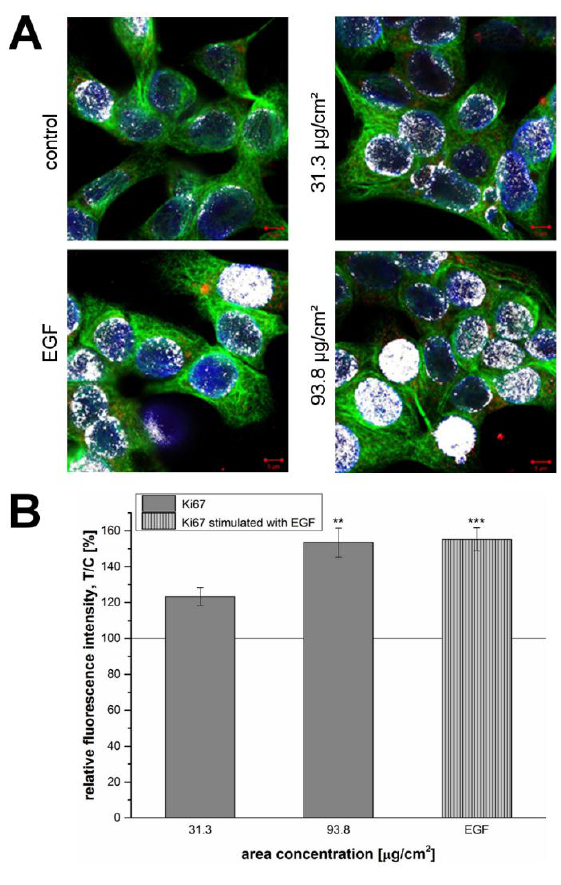
Figure 6. ( A ) Representative appearance of Ki-67 and Lamin B in GXF251L cells treated with 12 nm SiO 2 NPs for 24 h after the application of the co-localization tool on the images. White fields represent the co-localization of Ki-67 (red) and Lamin B (blue). α -Tubulin is presented in green. Scale bars are equivalent to 5 µ m; ( B ) Quantification of the red fluorescence associated with Ki-67 nuclear staining. [%]). The solid line represents the negative control set to 100%. Statistical analysis was performed by Student’s t-test. Significances indicated as * refer to a comparison to the samples treated with SiO 2 NP concentration of 31.3 µ g/cm 2 . (** ≡ p ≤ 0.01 and *** ≡ p ≤ 0.001; 31.3 µ g/cm 2 n = 66 nuclei; 93.8 µ g/cm 2 n = 72 nuclei; EGF n = 67 nuclei).